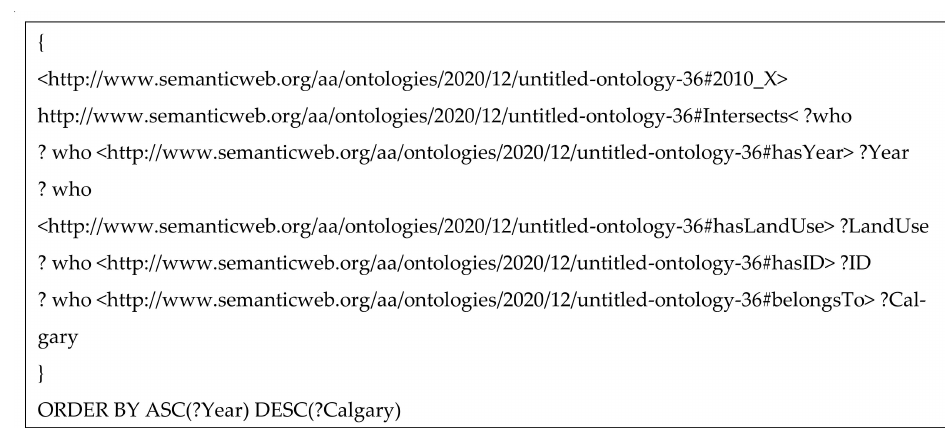
Figure 6. ( a ) Pseudo code of the semantic query. Example semantic query triplets using SPARQL: ( b ) the land use composition; ( c ) the semantic query for the land use change at the case study area (2010_X) from 2010 to